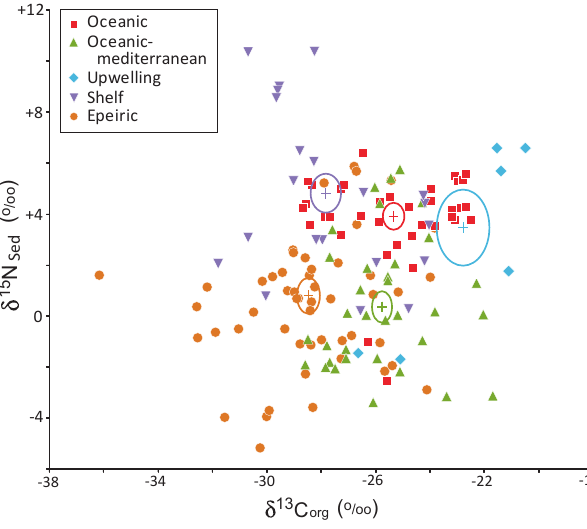
Fig. 4. δ 15 N sed versus C org :N ratio. Average composition of mod- ern marine plankton shown by red star, and approximate compo- sitional range of terrestrial (i.e., soil-derived) organic matter by green rectangle. Note that the pattern of negative covariation be- tween δ 15 N sed and C org :N is not clearly associated with a terres- trial endmember and does not provide evidence of pervasive mixing of marine and terrestrial organic matter in our study